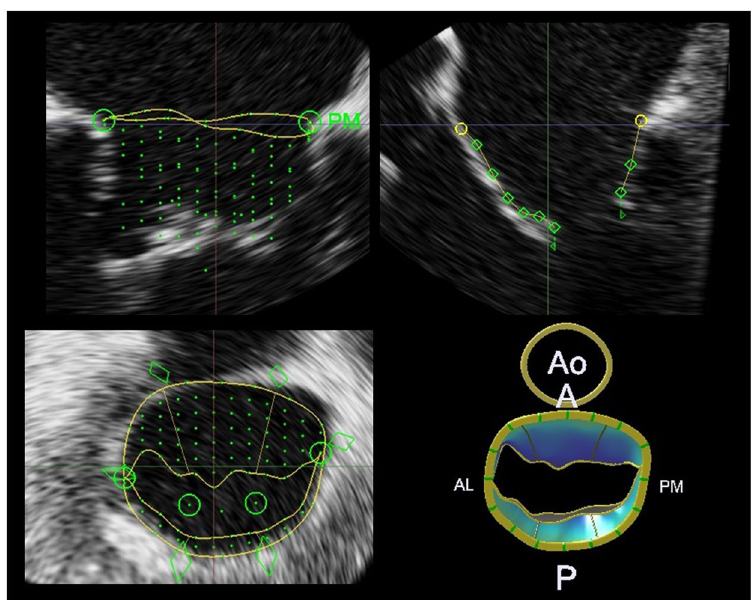
Figure 2. Three-dimensional (3D) mitral valve (MV) morphological analysis in a mid-diastolic frame using MV Navigator A.I . (MVN A.I. ). The mitral annulus was manually initialized; then, both the anterior mitral leaflet (AML) and posterior mitral leaflet (PML) were manually traced. The result was displayed as a color-coded model and each parameter was automatically calculated. AL, anterolateral; PM, posteromedial; Ao, aorta; A, anterior; P,